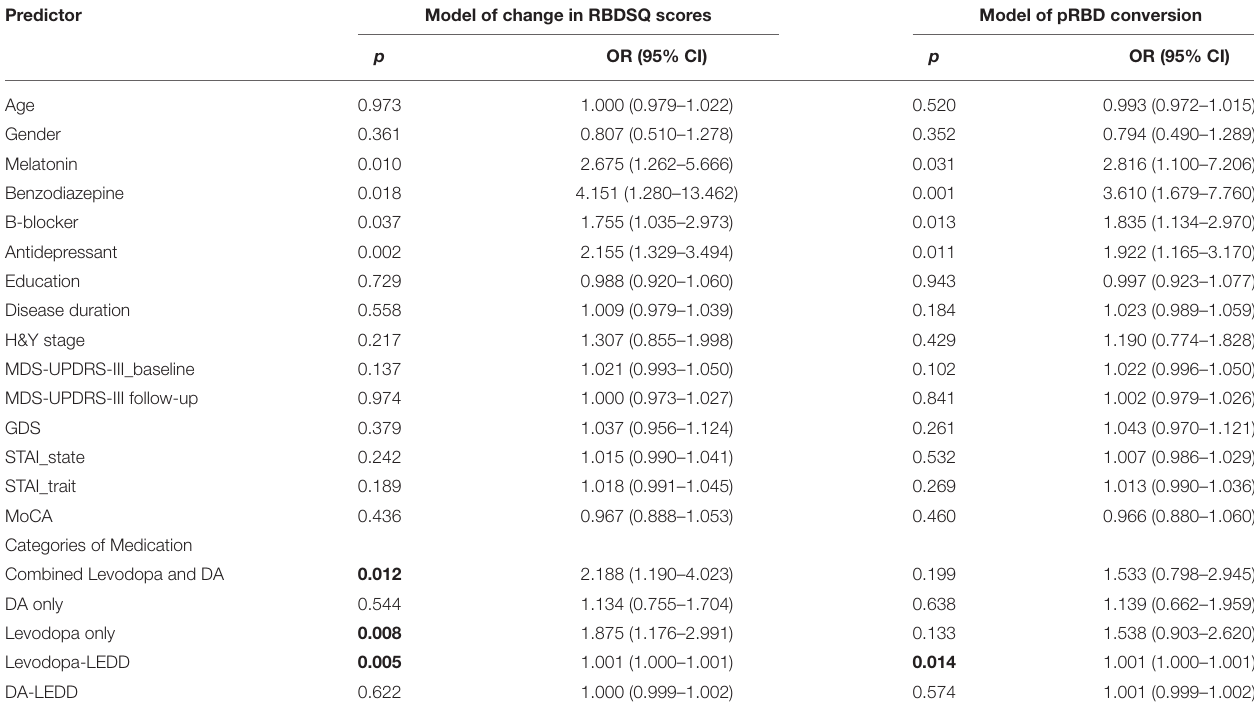
TABLE 3 | Predictors of the evolution of RBD symptoms in the PD-pRBD- group.